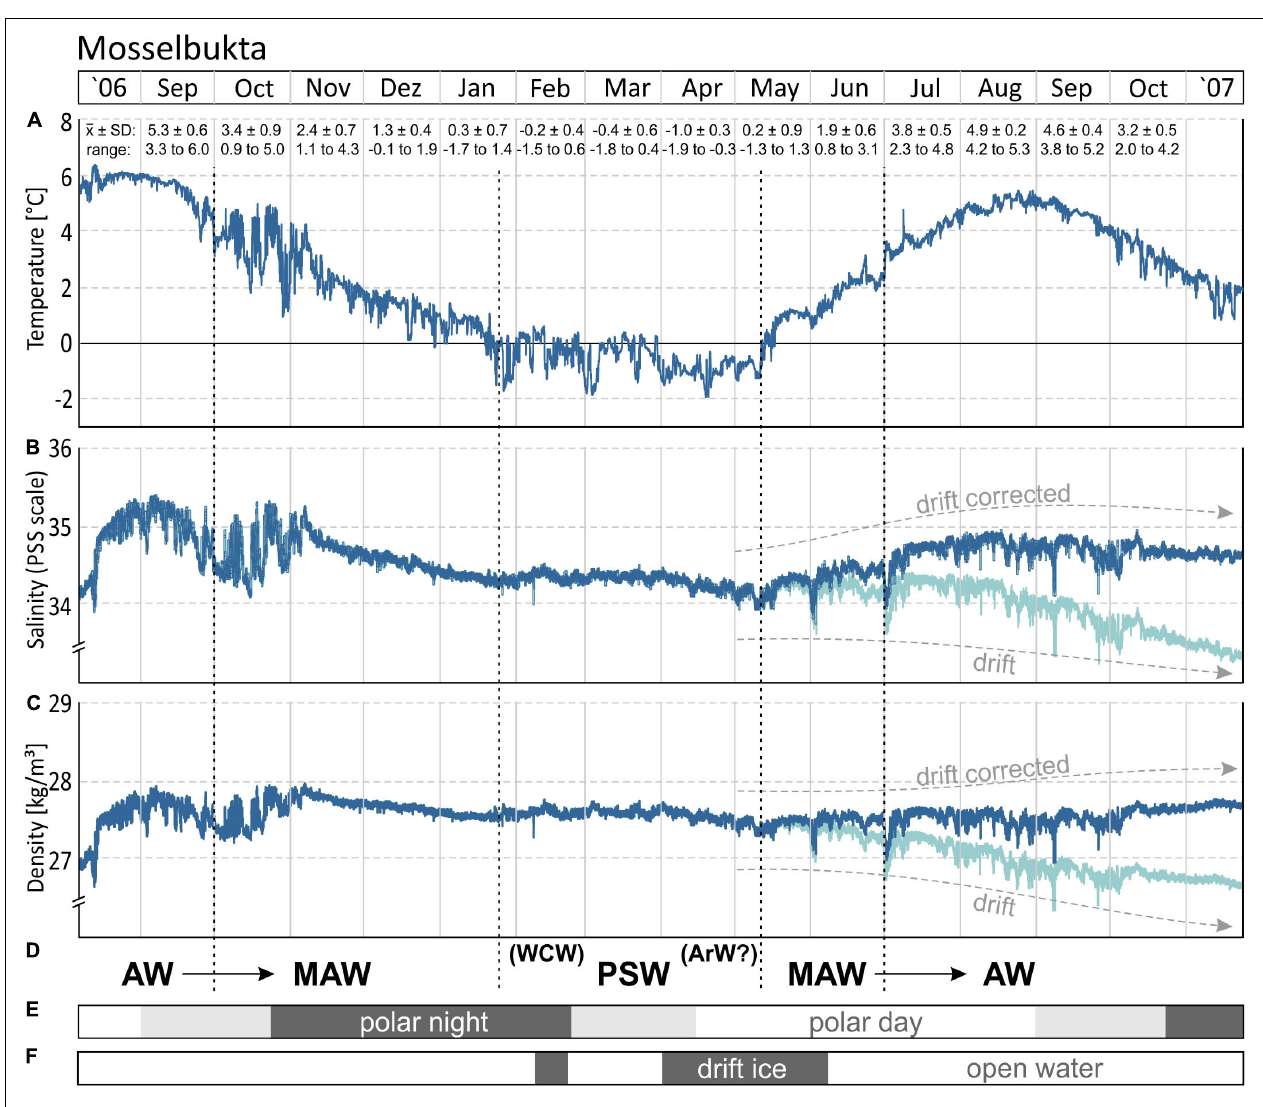
FIGURE 3 | (A,B) The 15-month temperature and salinity record logged by the CT logger on a settlement platform that was deployed in August 2006 at 46 m water depth in Mosselbukta. The decrease during the last 5–6 months in the salinity record likely is a drift artefact (see also Figure 4 ), for which a drift correction was applied. (C) Seawater density (sigma theta) calculated from temperature and salinity. (D) Determined water mass changes through the investigated period: Atlantic Water (AW), Modified Atlantic Water (MAW), Winter Cooled Water (WCW) and Arctic Water (ArW) contributing to Polar Surface Water (PSW). (E) The duration of